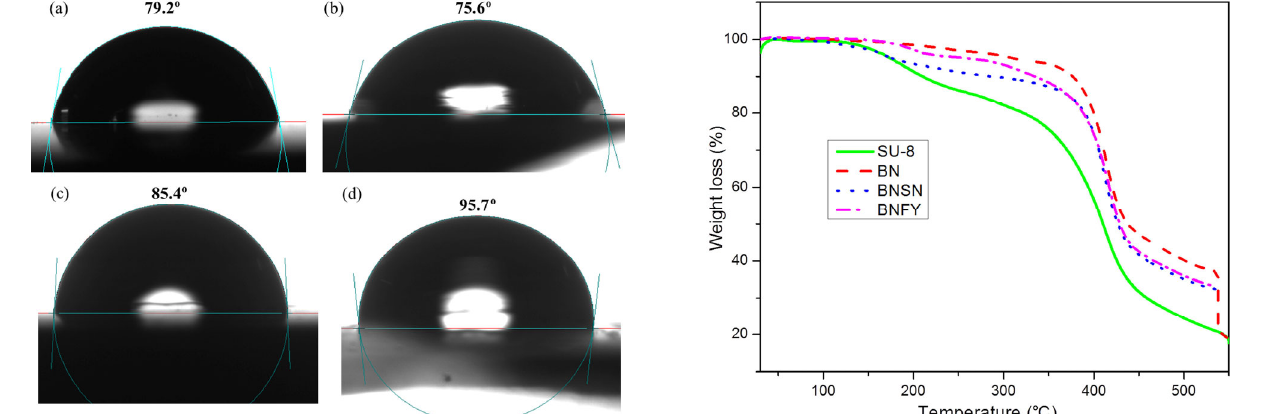
Fig. 6 TGA spectra of SU-8 and its